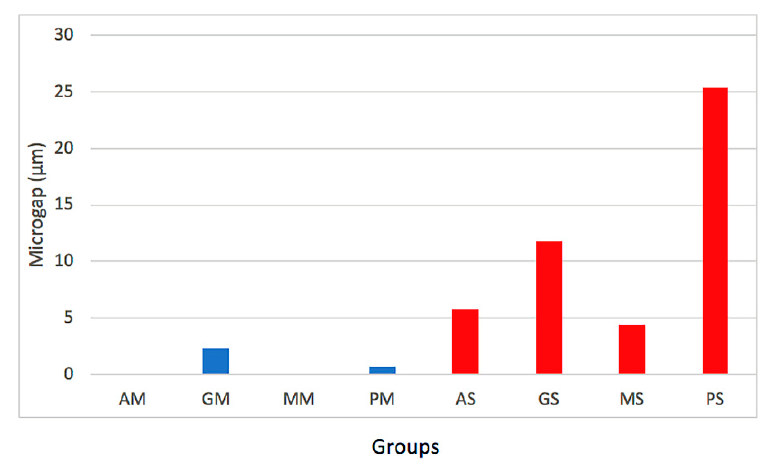
Figure 4. Graph of misfit values among the groups. Table 5. Pairwise comparisons.